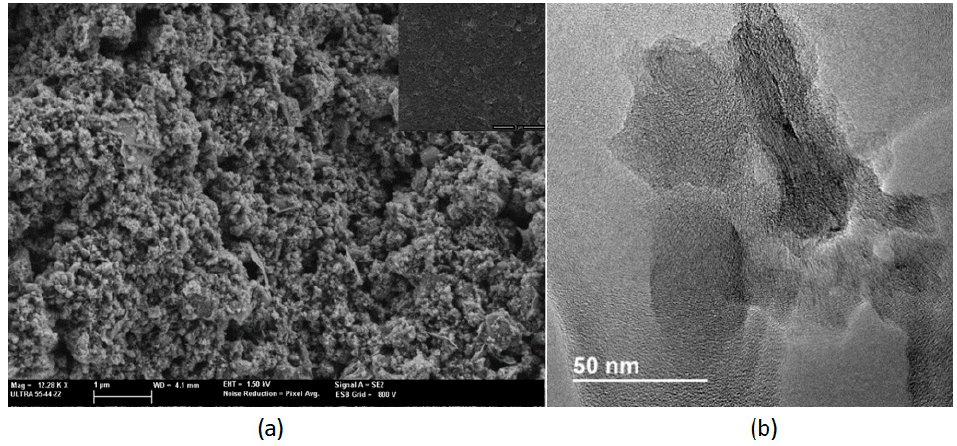
Figure 7. FESEM image showing the graphene sensor surface ( a ). HR-TEM image showing an example of the graphene layers size ( b